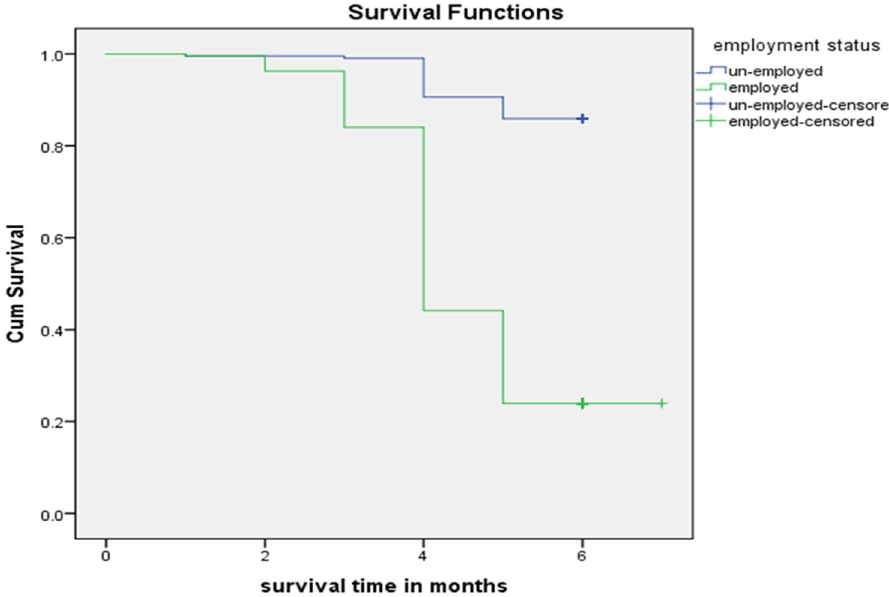
Figure 2. Kaplan–Meier cumulative survival probability functions of EBF for children of employed and unemployed mothers in Debre tabor town, South Gondar Zone, North West Ethiopia,